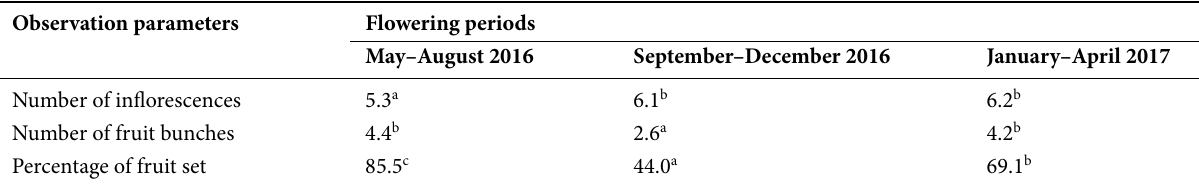
Table 1 Total average number of inflorescences and fruit bunches and the percentage of fruit set during the three flowering periods of the Sidimpuan snake fruit.